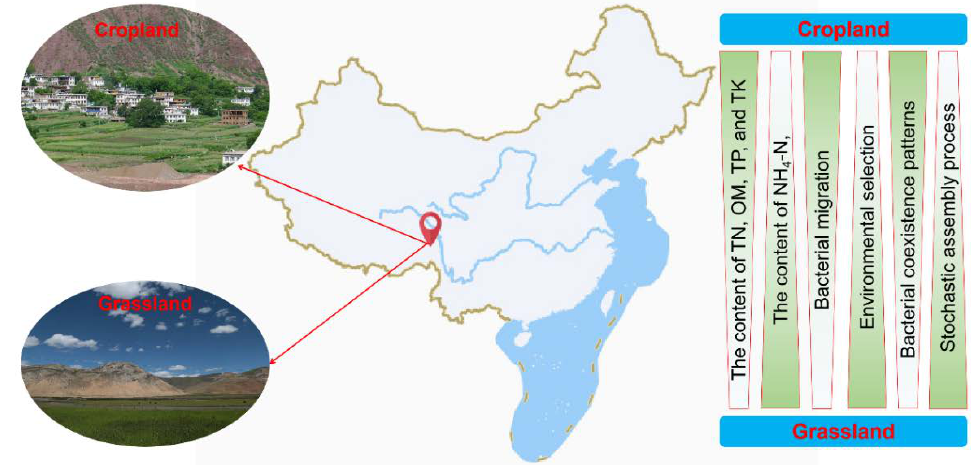
Figure 7. The conceptual model reveals the differences in the composition and assembly patterns of soil nutrients and bacterial communities in cropland and grassland. Green shows a decreasing trend from dark to light.